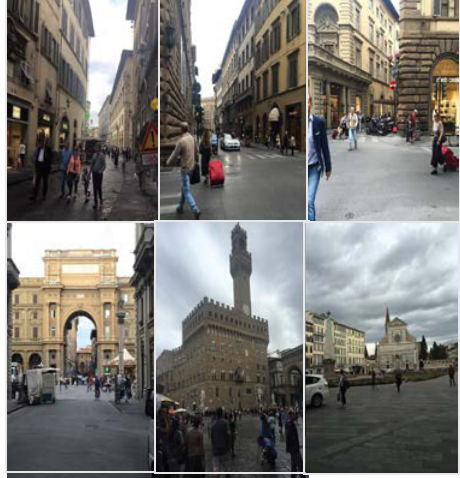
Figure1 Photo Credits to Arch. Marialena Kampani Figure2 Photo Credits to I.D. Joy